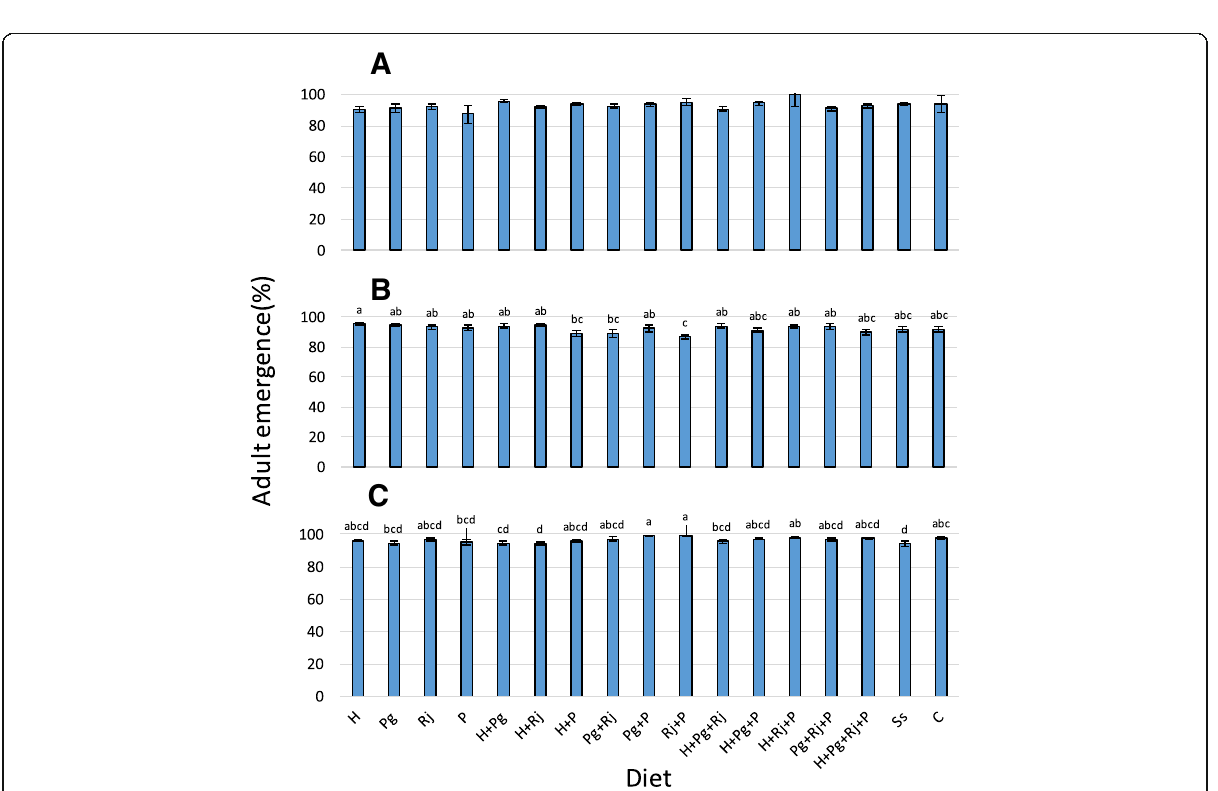
Fig. 4 Emergence rate of a T . evanescens , b T . bourarachae , and c T . cacoeciae supplied with different diets and the control